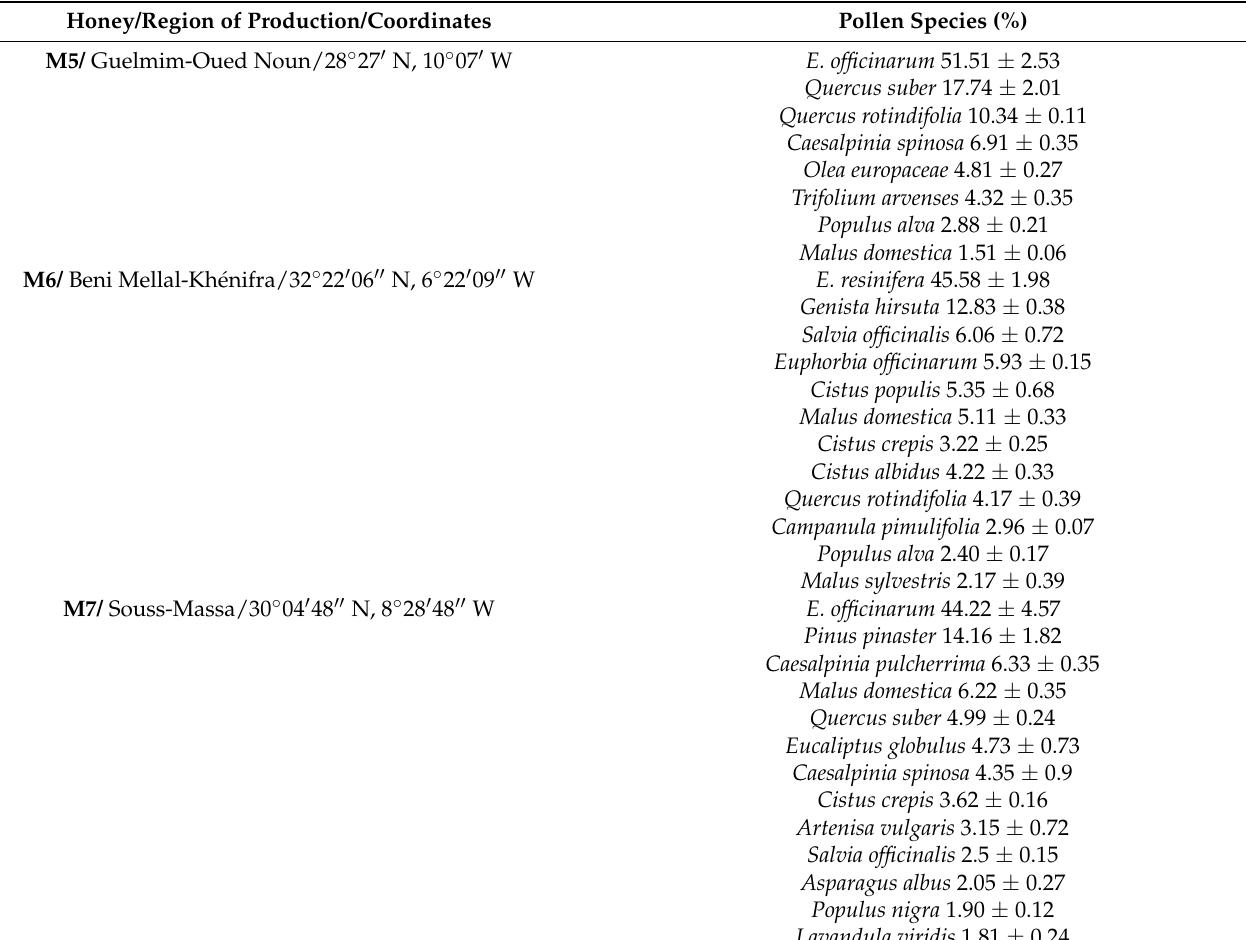
Table 1. Cont. Honey/Region of Production/Coordinates Pollen Species